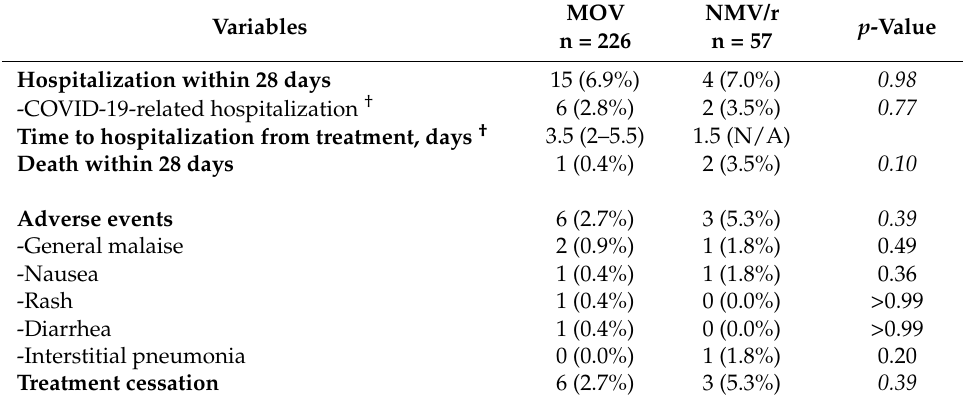
Table 2. Incidence of hospitalization, death, and adverse events according to the drug type.